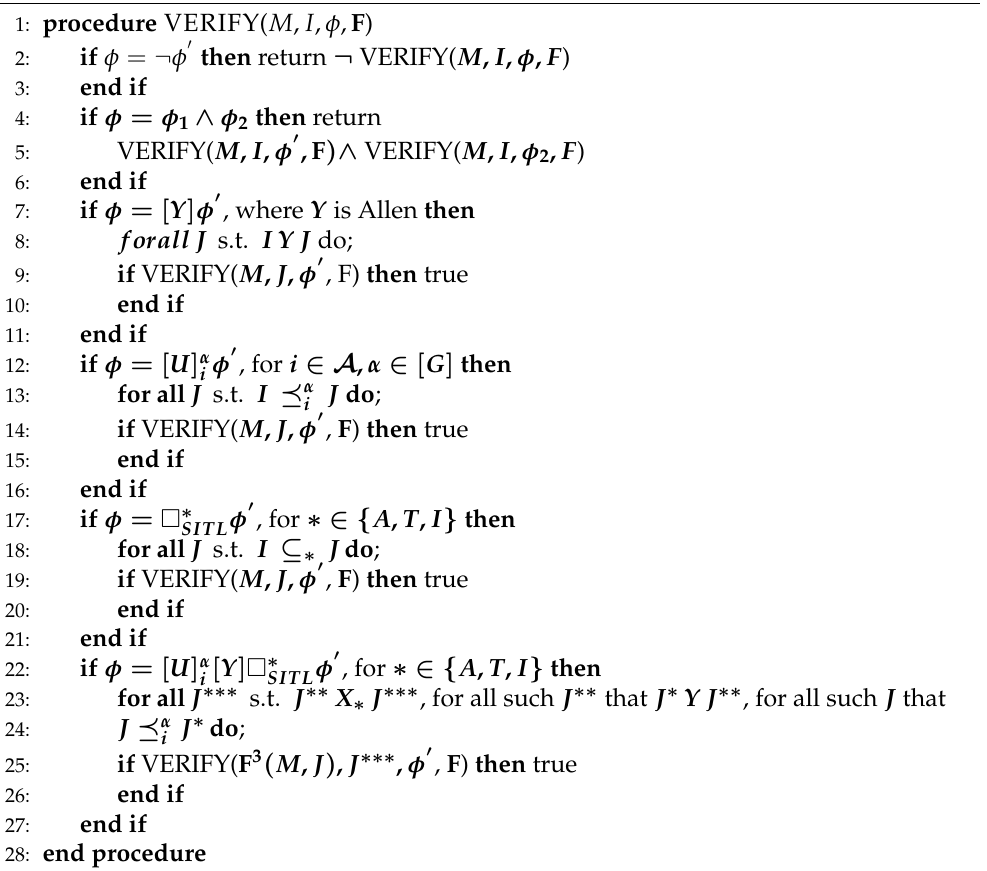
Algorithm 1 Model checking for